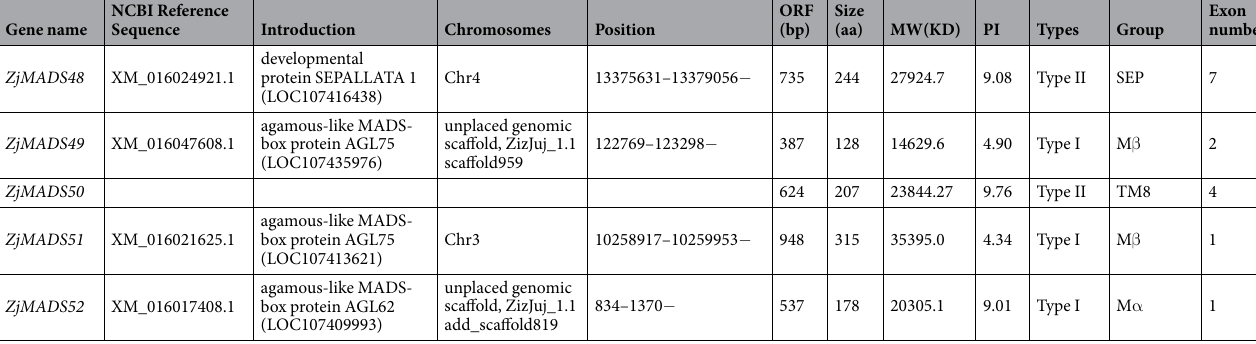
Table 1. The information of MADS gene family in Chinese jujube.